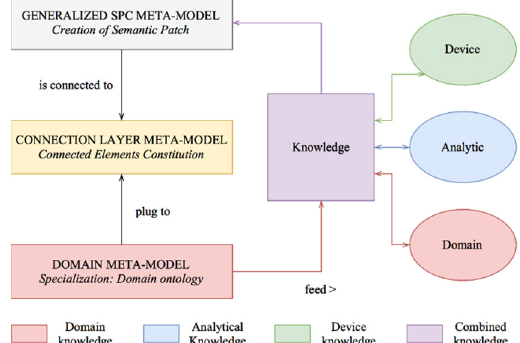
Figure 1 Meta-model articulation for the creation of a SPC